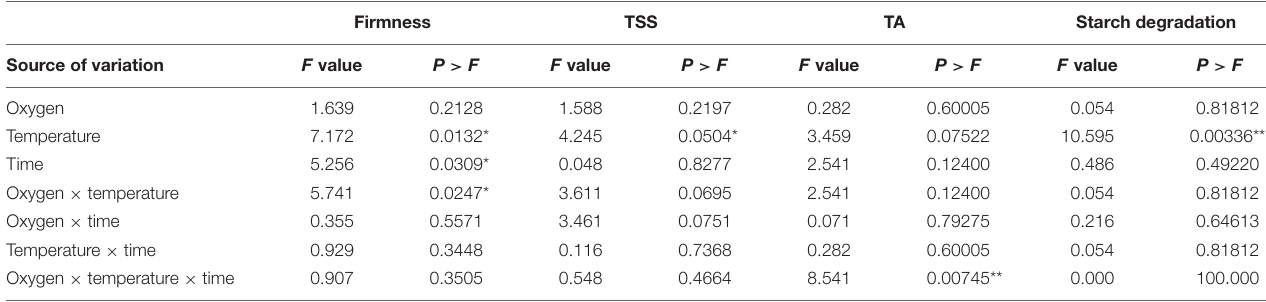
TABLE 1 | Individual and interaction effects of ultra-low oxygen (ULO) conditioning treatments: oxygen concentration (0.5 and 21 kPa), temperature (0 and 5 ◦ C), and time (15 and 30 days) on Fuji apple quality parameters after 90 days at 0 ◦ C. Firmness TSS TA Starch